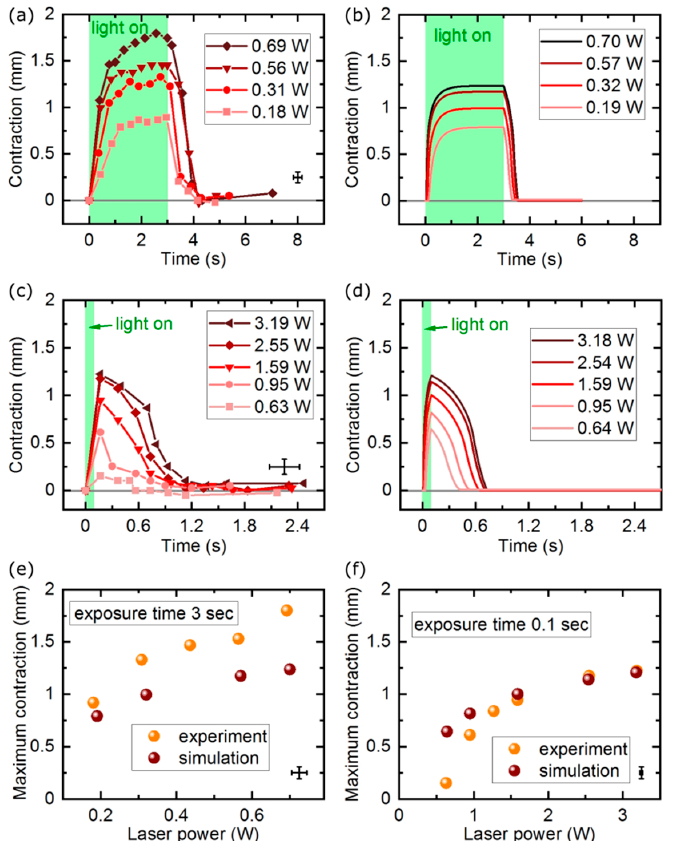
Figure 2. Linear actuator response with continuous and pulsed illumination. Measured and simulated actuator contraction vs. light power with long (CW) light exposure. ( a , b ) measured and simulated actuator contraction vs. light power with short (pulsed) light exposure; ( c , d ) measured and simulated maximum stroke for the CW illumination ( e ) and pulsed illumination ( f ).